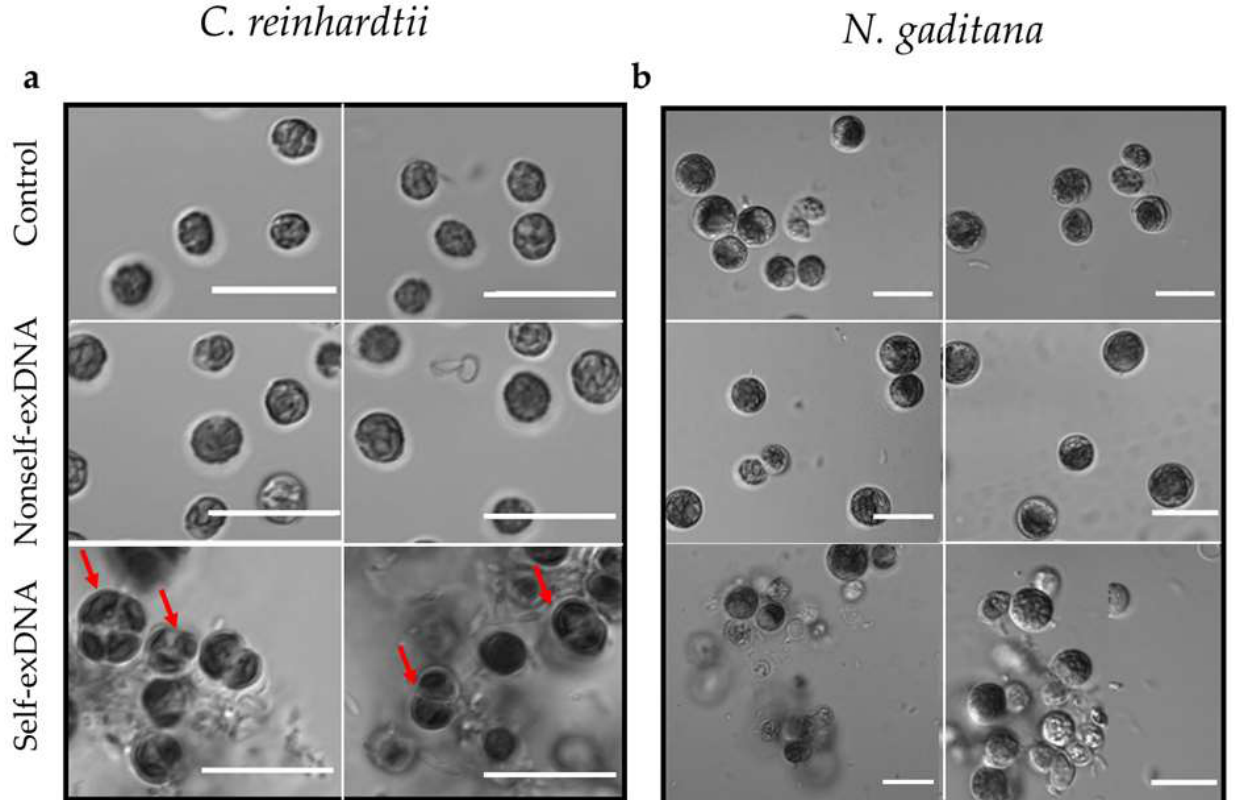
Figure 3. Light microscopy analysis of microalgae cells. C. reinhardtii ( a ) and N. gaditana ( b ) samples in controls and after treatments with nonself- and self-exDNA. Focus on the cell morphology showing aggregates and/or structural changes occurring only after treatments with self-exDNA at 30 ng/µL. In ( a ), red arrows indicate cells resembling a palmelloid stage (Scale bar = 10 µm). Microscope: Zeiss LSM 700, Oberkochen, Germany, Objective: 63× 1.40 Oil Dic.